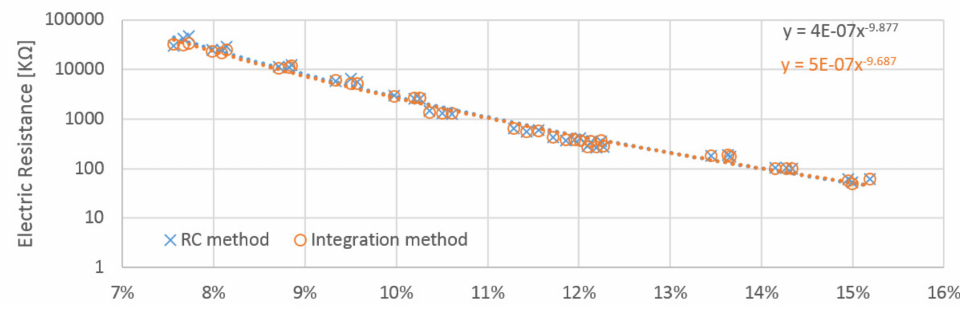
Figure 12. Obtained resistances from the integration and RC methods, the values calculated with the “C” probes placed in the cross